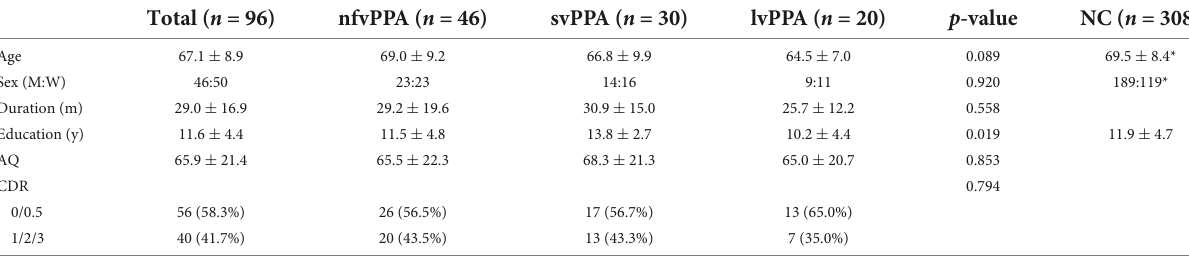
TABLE 1 Demographic variables and AQ of the patients with primary progressive aphasia.